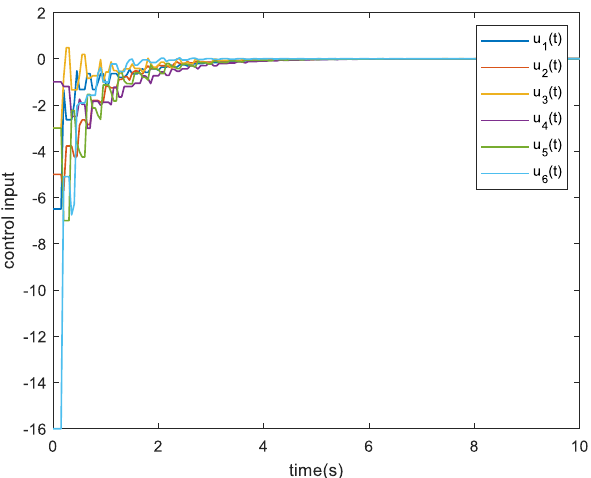
Figure 3. Control inputs for the agents.